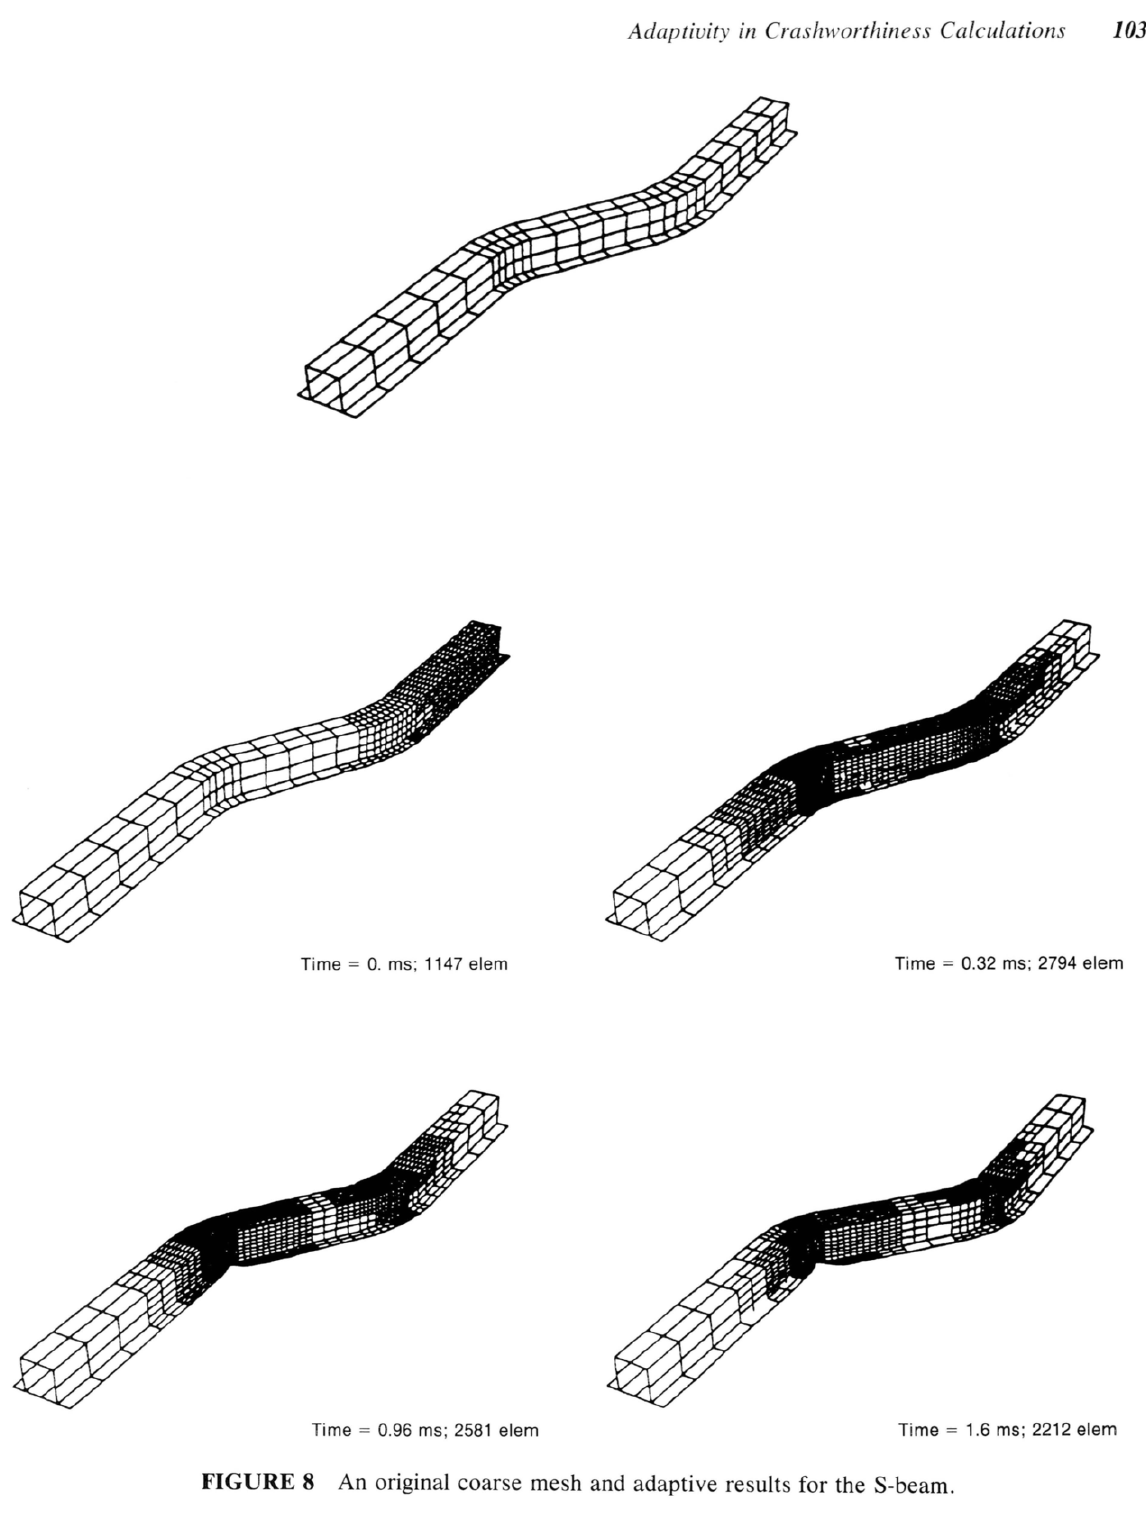
FIGURE 8 An original coarse mesh and adaptive results for the